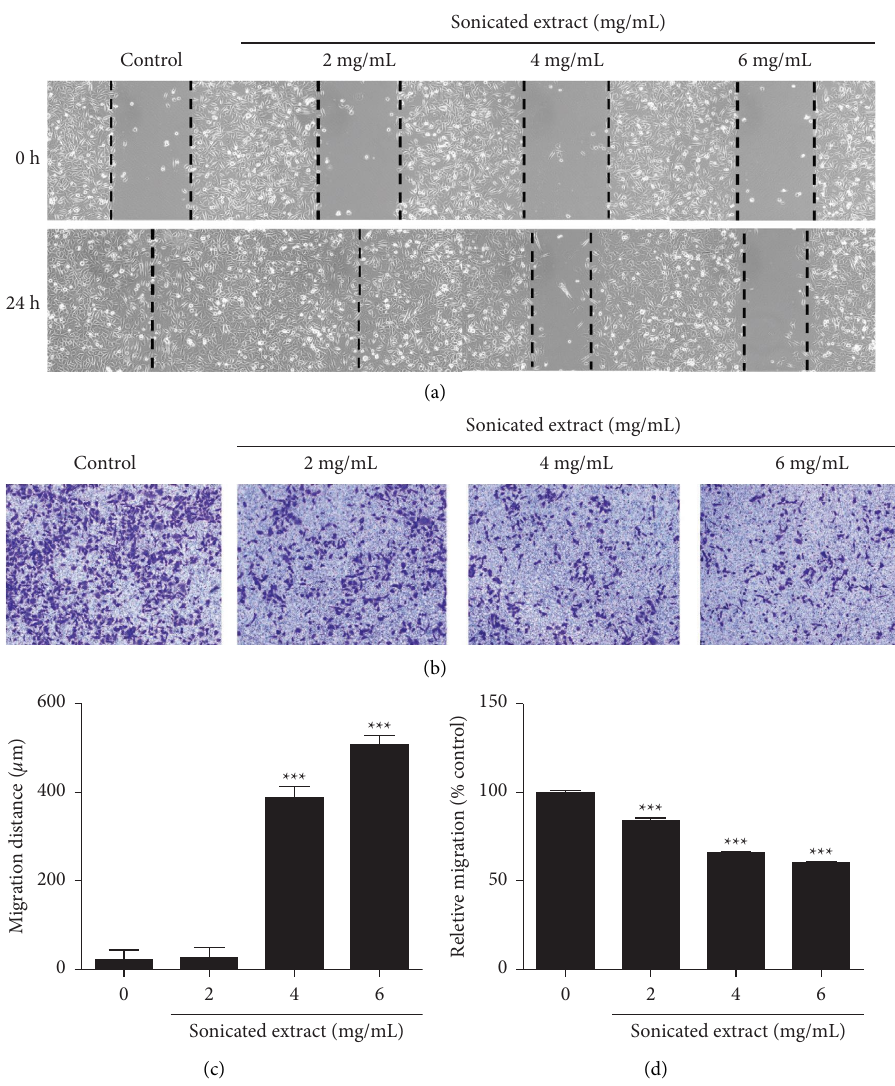
Figure 5: Inhibitory efect of the sonicated extract on PC-3 cell migration. PC-3 cells were treated with sonicated extract at 0, 2, 4, and 6 mg/ mL and incubated for 24h. (a) Te migration of PC-3cells was measured using a wound healing assay. After 0 and 24h of migration, the scratches were photographed. (b) Te migration of PC-3 cells was measured using the transwell insert migration assay. (c) Te migration distance was calculated. (d) Te relative migration of PC-3 cells was determined as described in the methods. All experiments were repeated three times. Data are presented as the means ± SEM ( n � 3), p < 0 . 01 ∗∗ , p < 0 . 01 ∗∗∗ versus the control